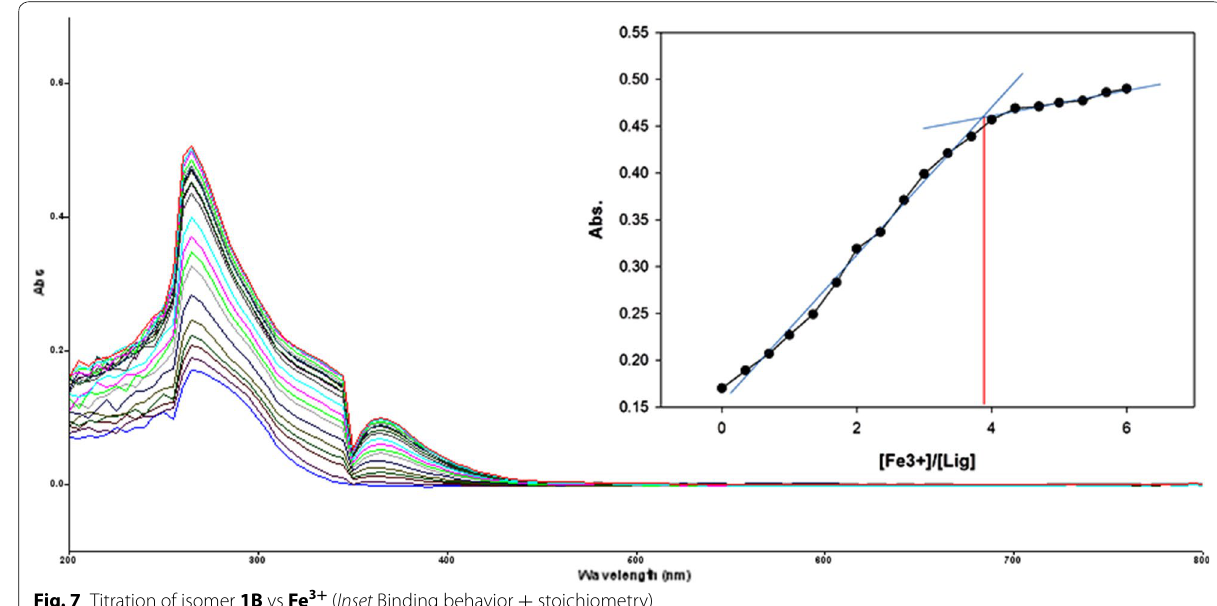
Fig. 7 Titration of isomer 1B vs Fe 3 + ( Inset Binding behavior